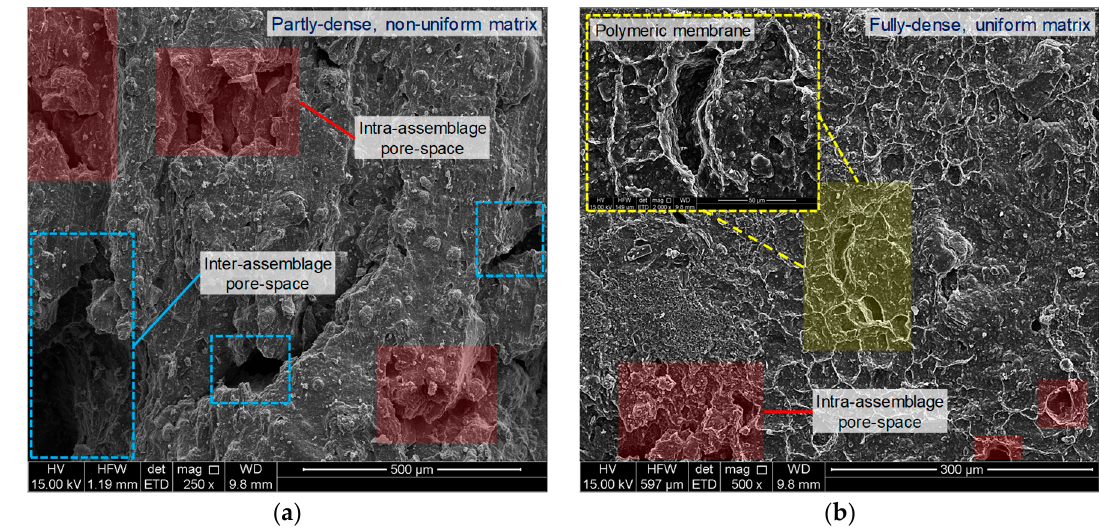
Figure 10. SEM micrographs for the tested samples: ( a ) SP 0 R 0 ; and ( b ) SP 0.2 R 0 .